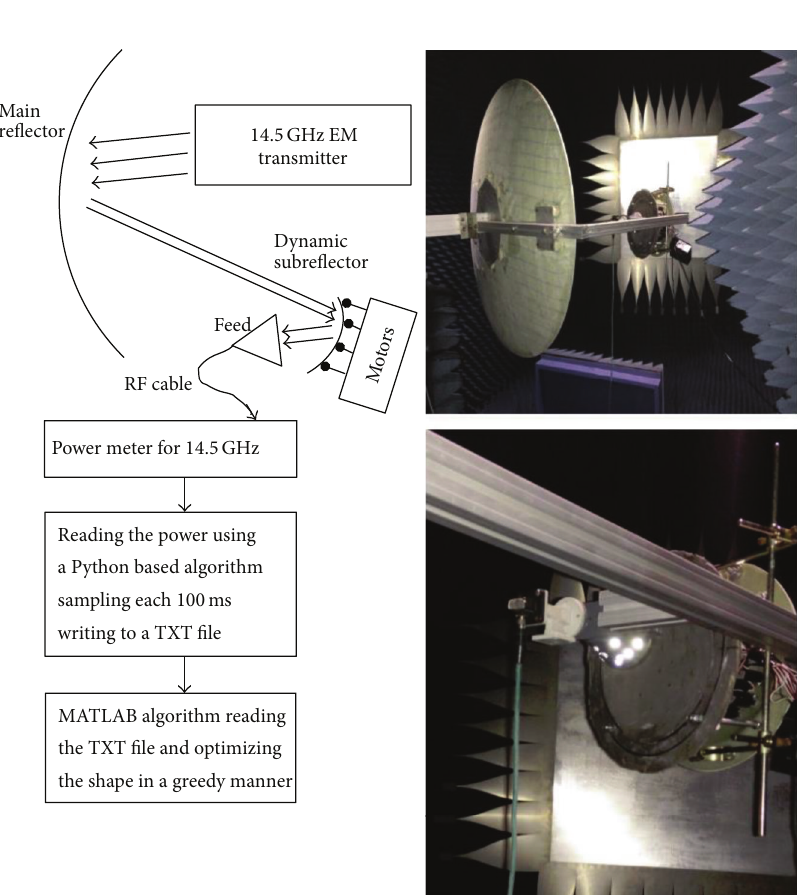
Figure 7: The general setting of the search algorithm as was implemented in the RF room experiment.